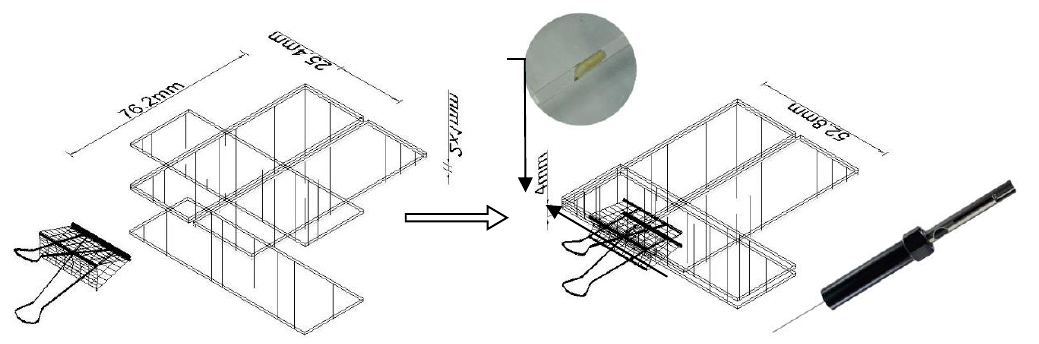
Figure 5. Experimental setup for SPME sampling of B. dorsalis larvae specimens. The larvae are fixed in a slit assembled by slide glasses and contacted with an SPME fiber.